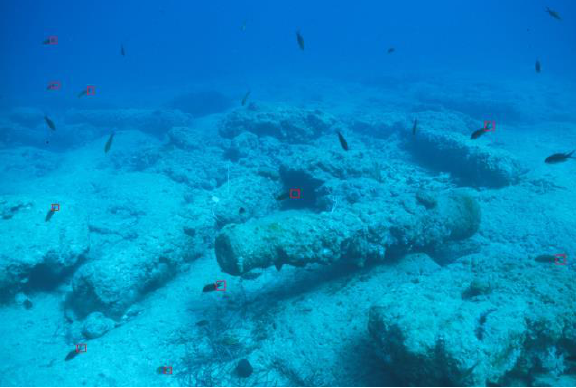
Figure 9. Results of shape detection for log-polar algorithm As expected the DODE algorithm is much faster but only identified the exact match with the fish tale used for shape to search (see fig 10 below).